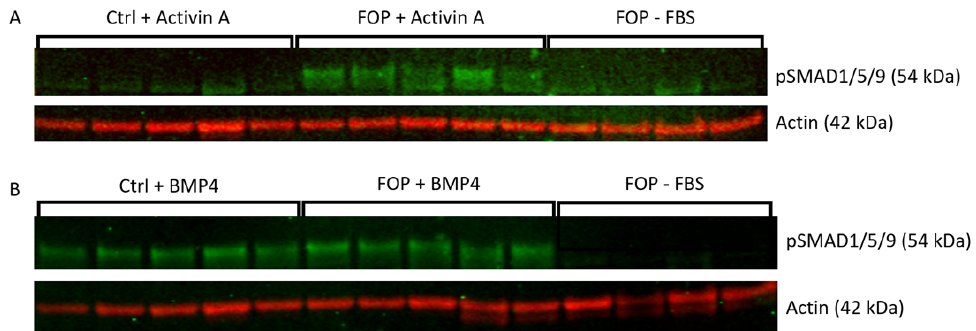
Figure 1. Expression of pSMAD1/5/9 in fibroblasts of FOP patients and controls by western blotting analysis. ( A ) Cells were serum-starved overnight before 60 min of stimulation with Activin A and ( B ) serum-starved overnight before 90 min of stimulation with BMP4. Actin was used to determine equal protein loading. - FBS are serum-starved unstimulated fibroblasts.